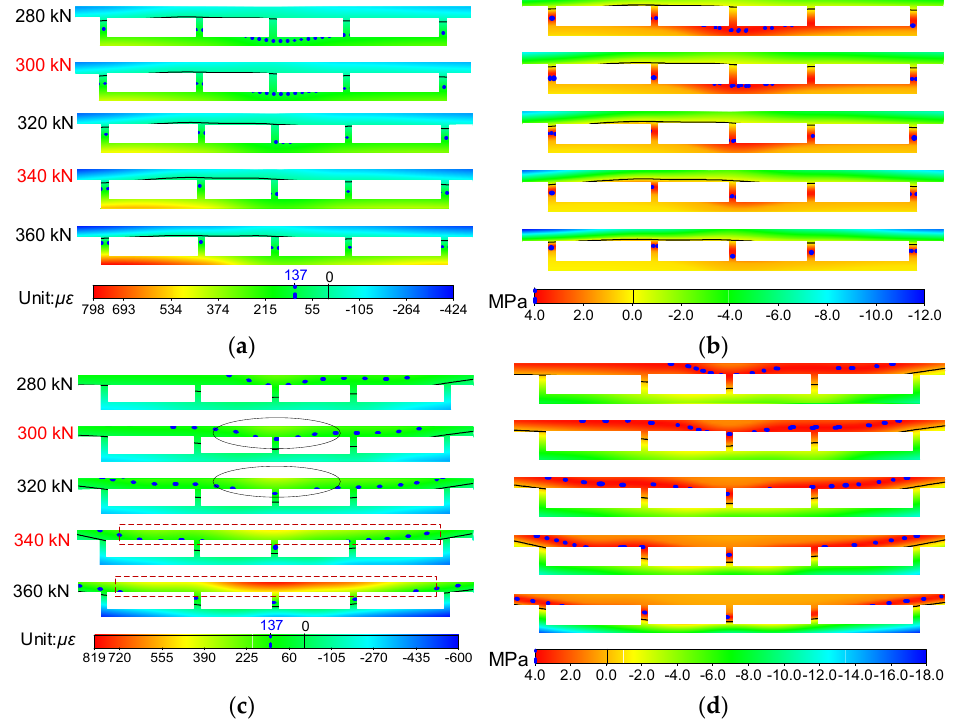
Figure 10. Strain and stress fields of the bridge model obtained by simulation: ( a ) strain fields of section A; ( b ) stress fields of section A; ( c ) strain fields of section B; ( d ) stress fields of section B.